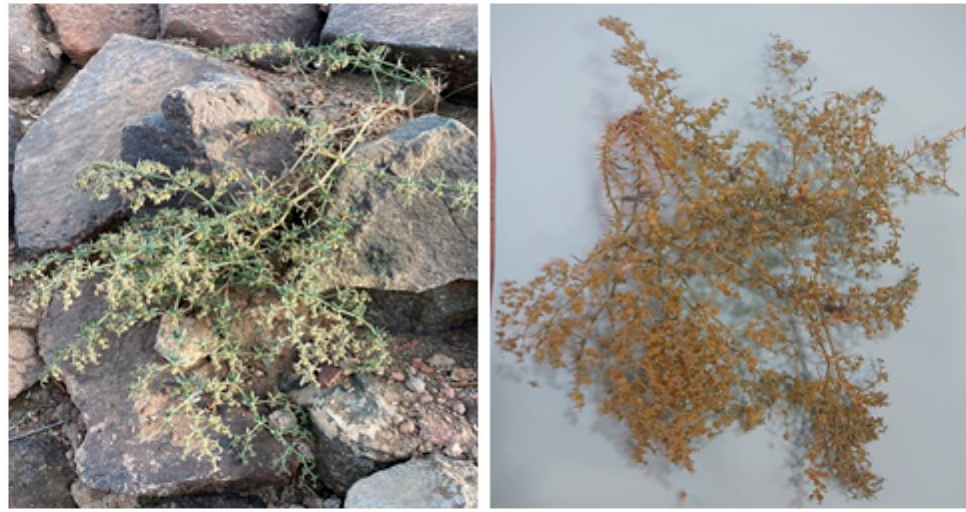
Figure 5. The areal parts of Fagonia indica .